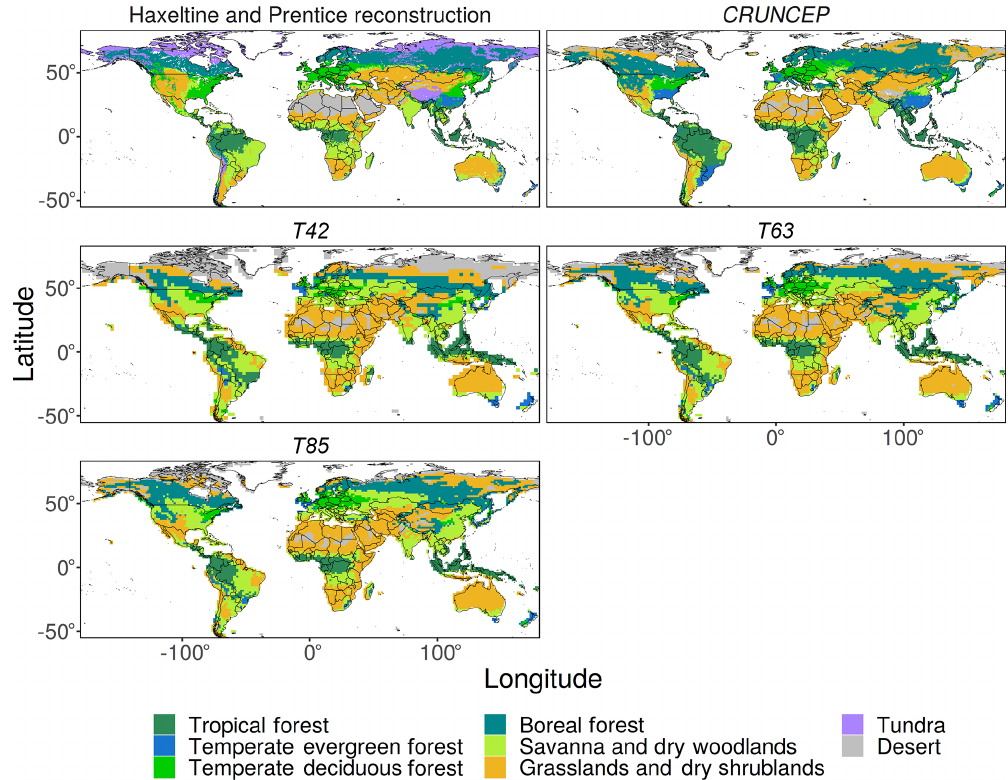
Figure 2. Distribution of PNV megabiomes simulated by LPJ-GUESS within EMAC ( T42 , T63 , and T85 ) and using observed climate data ( CRUNCEP ) compared to an expert-derived PNV map (Haxeltine and Prentice, 1996) following a reclassification (Smith et al., 2014; Forrest et al.,